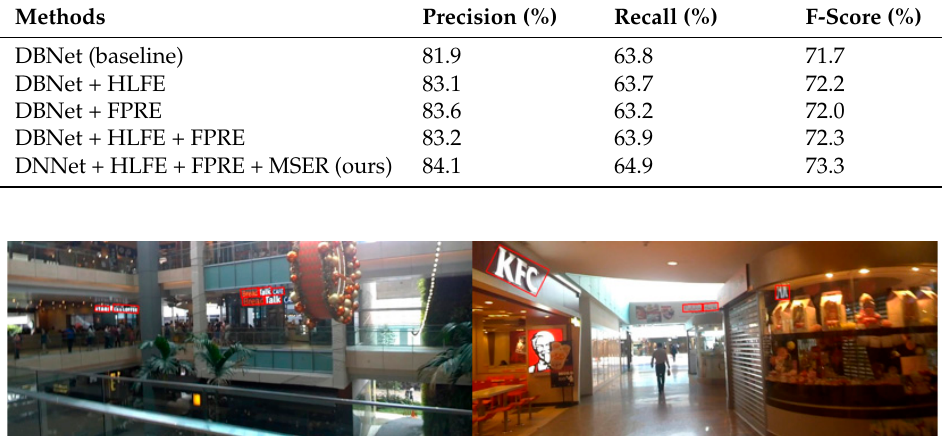
Table 4. Comparison of results of ablation experiments on the ICDAR2017-MLT dataset. Methods